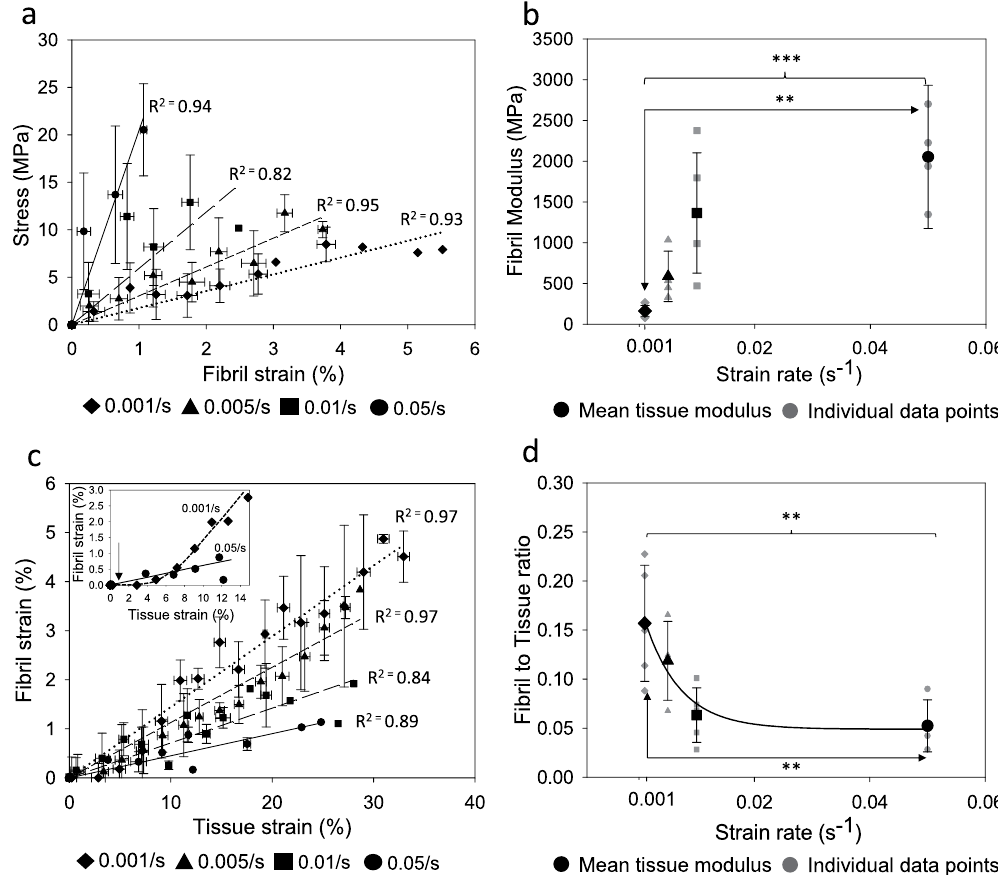
Figure 2. Fibril level ligament properties ( a ) Stress vs. fibril strain % (n = 5 for each strain rate, error bars are SD). Lines are linear regressions. ( b ) Fibril modulus (individual data points and means ± SD for n = 5) ( c ) Fibril vs. tissue strain (n = 5 for each strain rate, error bars are SD). Lines are linear regressions. Insert showing fibril vs. tissue strain data shown for the fastest and slowest strain rates tested in this study. The arrow is pointing to the toe region of the slow strain rate curve. ( d ) Fibril to tissue strain ratio (individual data points and mean ± SD for n = 5). ( * p < 0.05, ** p < 0.01, *** p < 0.001.)